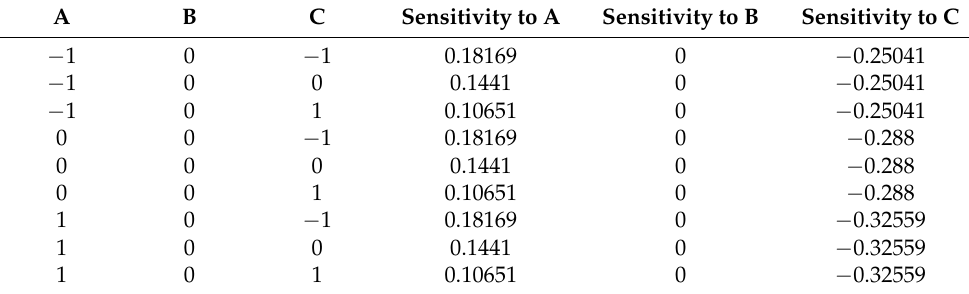
Table 8. Sensitivity analysis of the response Nu x